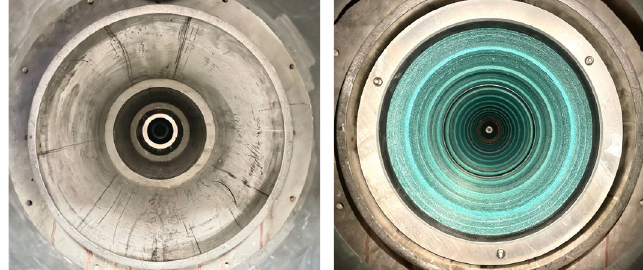
Fig.5. The RSEC – NIF beam port (view towards the reactor); OB (left) and CB (right).